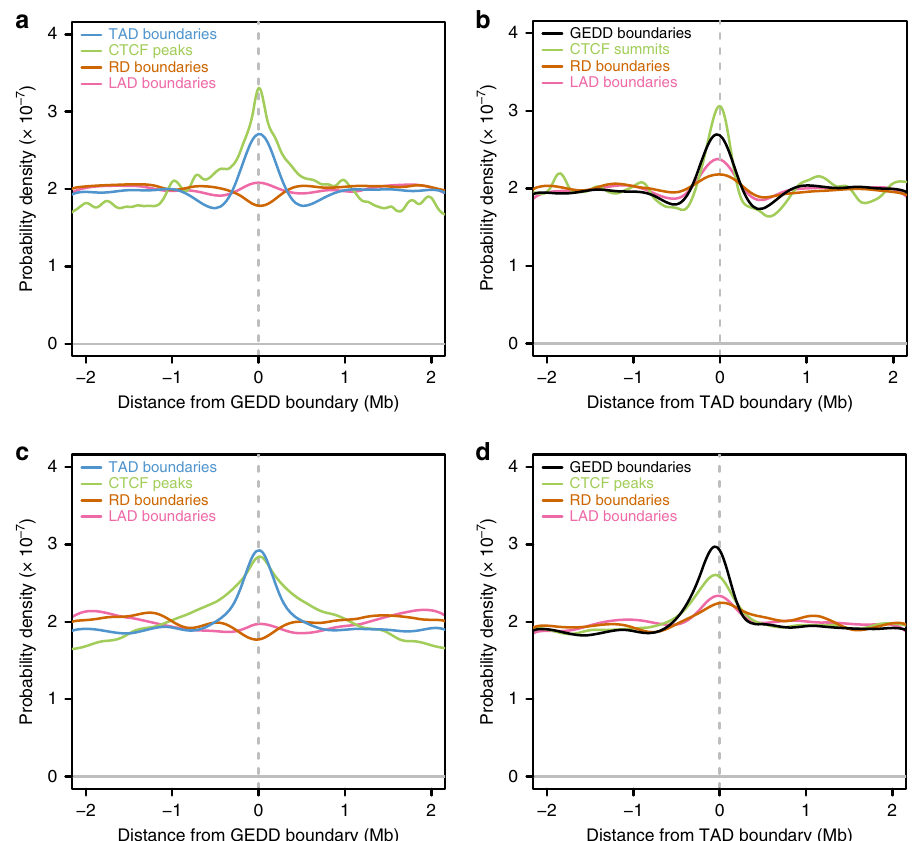
Fig. 8 Boundaries of gene expression dysregulation domains (GEDDs) correlate with boundaries of topologically associating domains (TADs) and CTCF- binding sites. a Probability density plot showing the distribution of boundaries of TADs, lamina-associated domains (LADs) and replication domains (RDs) and CTCF-binding sites, all from mouse embryonic fi broblasts (MEFs), relative to a region of ±2.2 Mb around GEDD boundaries derived from the comparison of Dp1Tyb and wild-type (WT) MEFs. b Same elements as in a compared relative to TAD boundaries. c Density plot showing the distribution of boundaries of TADs from the cortex, boundaries of LADs and RDs from neural precursor cells and CTCF-binding sites from hippocampus relative to GEDD boundaries derived from the comparison of Dp1Tyb and WT hippocampus. d Same elements as in c compared relative to TAD